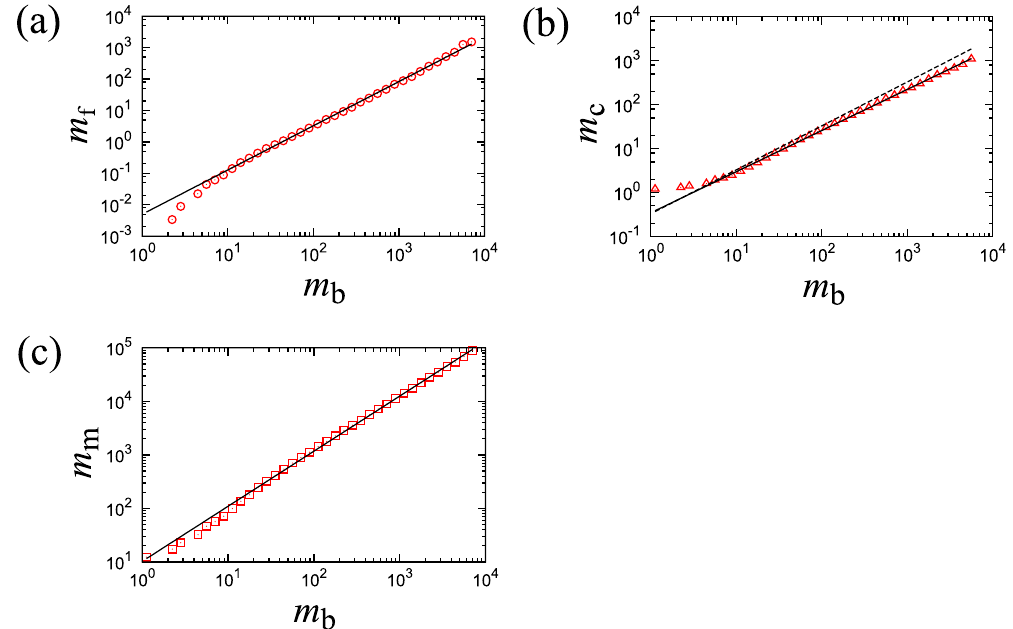
Figure 4. Scaling relationships for the real business network. ( a ) The number of bone links m b vs, the number of fat links m f by cluster in log-log scale. Plots are averaged using log scaled bins over 100 trials. The guideline shows the power law with a scaling exponent of 1.4. Error bars are omitted because the interquartile range (IQR) is as large as the size of the symbols in most plots. ( b ) The number of bone links m b vs, the number of cartilage links m c by cluster in log-log scale. Plots are averaged using log scaled bins over 100 trials. The guideline shows a power law with the scaling exponent of 0.94. Error bars are omitted for the same reason as in the previous plot. The dotted line shows a slope of 1.0 for reference. ( c ) The number of bone links m b vs, the number of muscle links m m by cluster in log-log scale. Plots are averaged using log scaled bins over 100 trials. The guideline shows the power law with a scaling exponent of 1.0. Once more, error bars have been intentionally